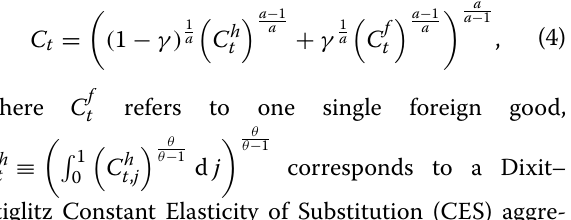
h t , j a domestic variety j . The h C f t is optimally chosen by t and